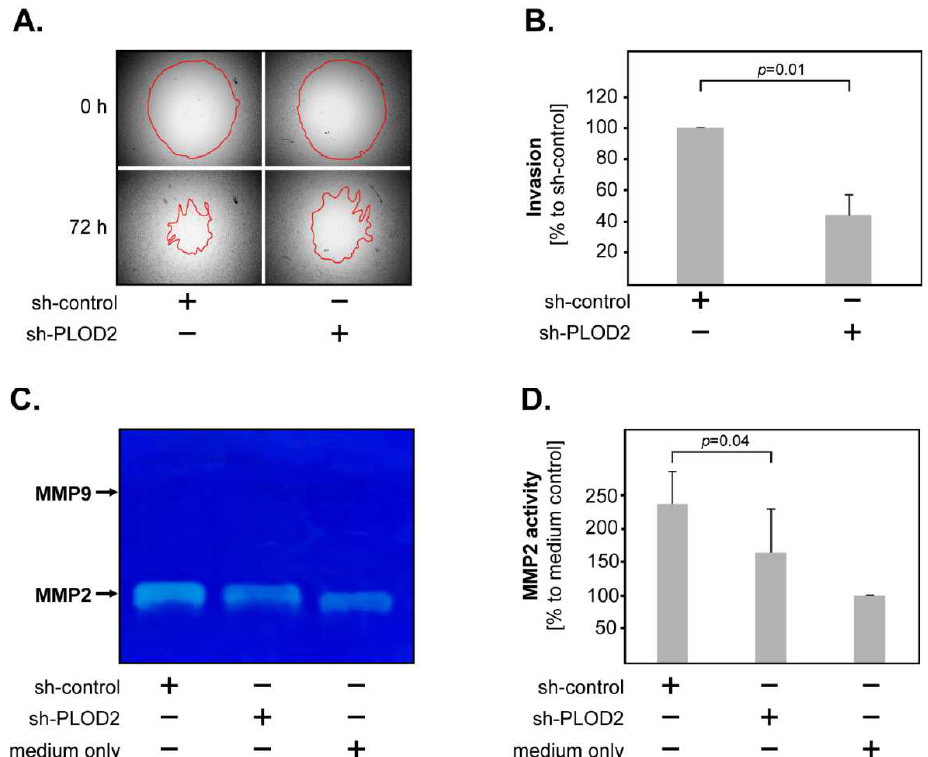
Figure 3. PLOD2 and GBM invasion. ( A ) Representative micrographs of invasion assays in sh- control versus sh-PLOD2 H4 cells. The upper panels show the pre-invasion status at 0 h, the lower panels show the post-invasion status at 72 h. The red line marks the closure of the “gap”, indicating the degree of tumor invasion. ( B ) PLOD2 knock-down significantly reduces the invasiveness of H4 cells. The data are presented as percentage to sh-control. ( C ) Representative image of a gelatin zymography gel showing that both sh-PLOD2 and sh-control released MMP2, but only negligible levels of MMP9. ( D ) PLOD2 knock-down significantly reduces the release of MMP2 in H4 cells. For quantification, the integrated density of the bands was determined using the ImageJ software. The data are presented as percentage to medium only. Shown are the means + S.D. of 3 independent experiments. Statistical analysis was performed with the paired t -test.